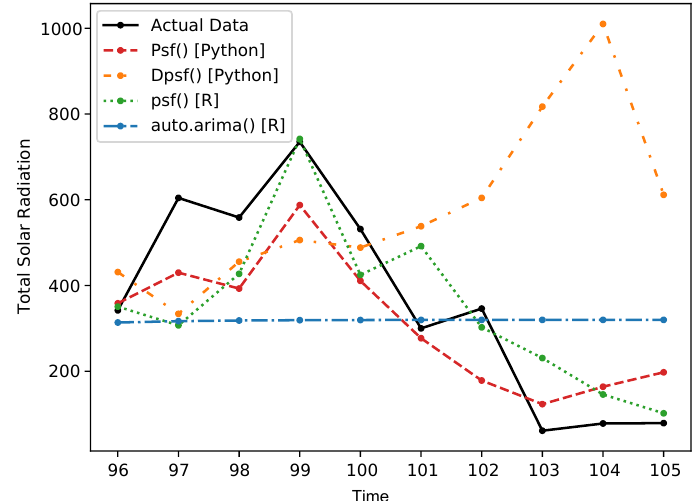
Figure 12. Plot showing the test data and values forecasted using various methods for the “Total Solar Radiation” dataset.